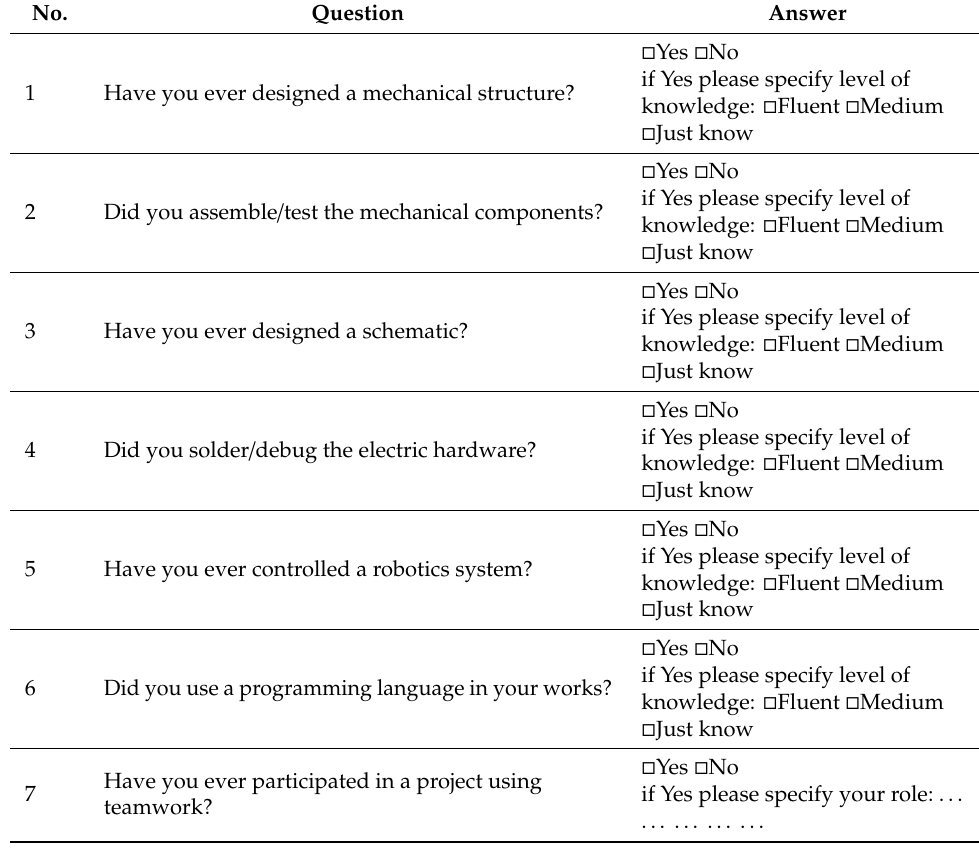
Table 2. Questionnaire to assess each learner’s